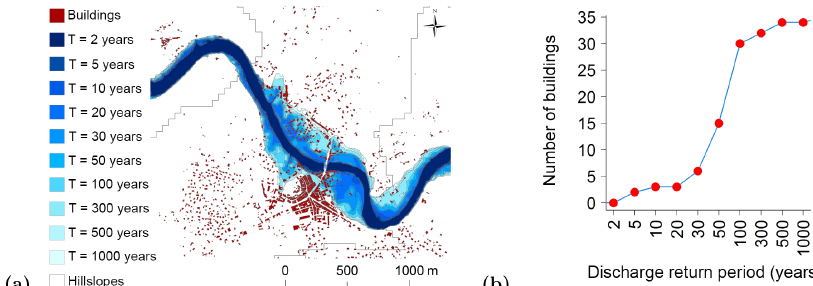
Figure 2. Illustration of the implementation of the impact model on one river reach: (a) catalogue of flooded areas, (b) interpolated discharge– impact